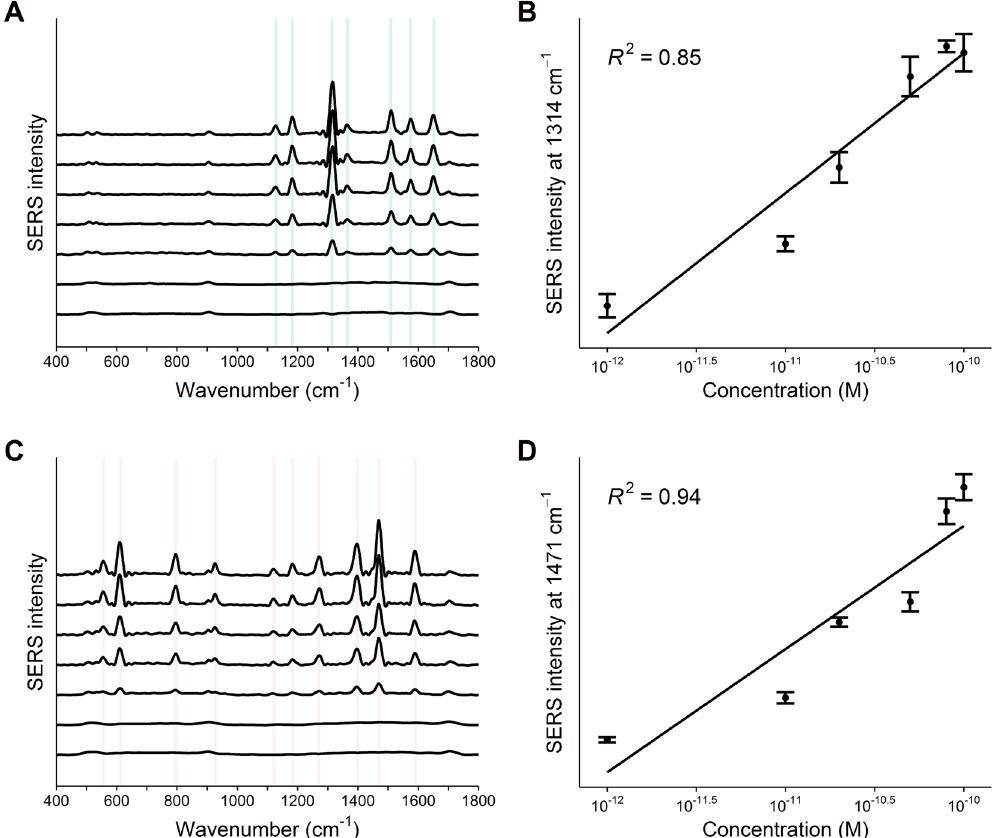
Figure 3. SERS spectra of PCR products of wild-type DNA mixed with increasing percentages of EGFR 19 ( A ) and 21 ( C ) mutations of 0%, 1%, 10%, 20%, 50%, 80%, and 100% (10 − 12 , 10 − 11 , 20 − 11 , 50 − 11 , 80 − 11 , and 10 − 10 M). ( B ) and ( D ) are peak intensity changes at 1314 cm − 1 and 1471 cm − 1 for EGFR 19 and 21 separately with the increasing mutation